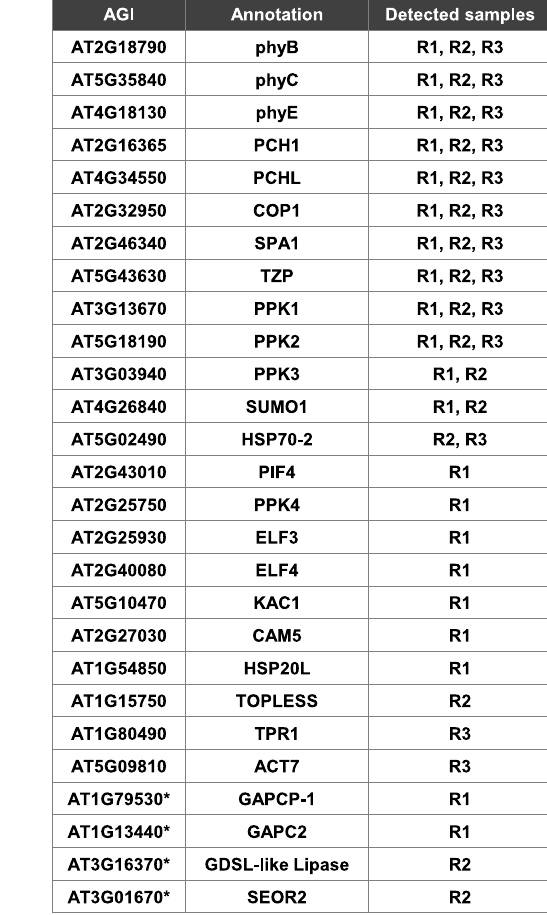
Fig. 2 | LC-MS-MS analysis of photobody components. a Histograms of normal- ized enrichment scores with fi tted normal distribution curves for three indepen- dentsamples(R1,R2,R3).TheLFQintensityofaproteinwasnormalizedbytheLFQ intensity of phyB in each sample (normalized LFQ). The enrichment score of a proteiniscalculatedbydividingthenormalizedLFQofaproteininasortedsample by the normalized LFQ of the same protein in the pre-sorted nuclear extract input sample. The distributions of logarithmic enrichment scores (Log 2 (Enrichment score))wereapproximatelynormalforallsamples(R 2 =0.9993forsample1,0.9971